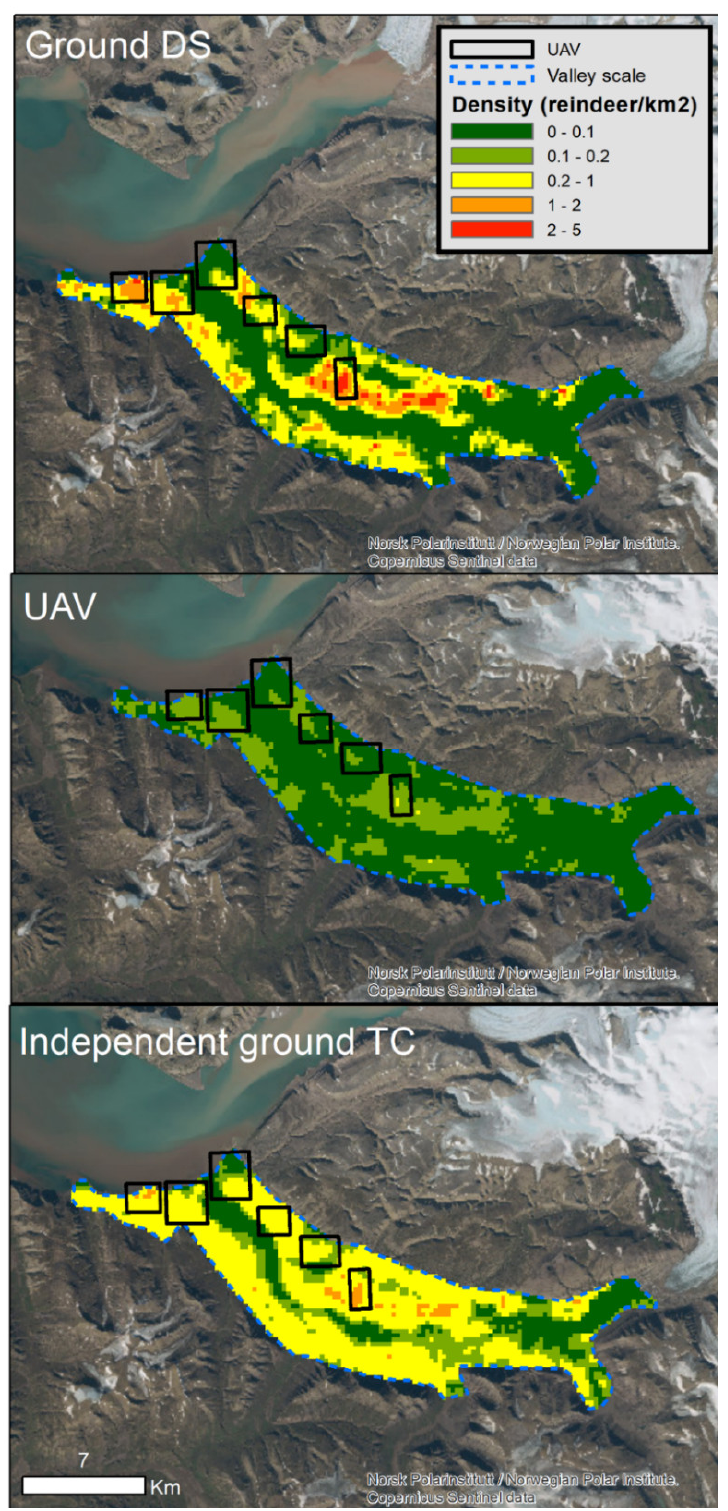
Figure 5. Predicted density (number of animals per km 2 ) of Svalbard reindeer based on density spatial models with maxNDVI as a covariate for the ground line transect distance sampling ( upper ), UAV survey ( middle ) and independent total counts model from a neighboring valley at the valley scale ( lower ). The map shows predicted densities at the valley scale for pixel resolution of 240 × 240